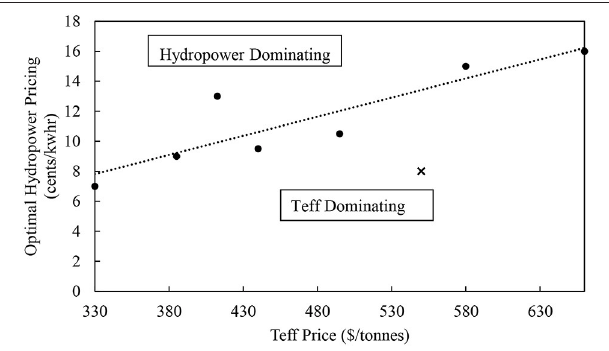
FIGURE 11 | The optimal hydropower pricing at different teff market prices (The red cross indicates the current market price for teff and the hydropower pricing set by Ethiopia). The horizontal axis shows different Teff market prices while the vertical axis shows the corresponding electricity price that should be set by Ethiopia to not lose benefits due to potential agricultural expansion. The cross corresponds to the nominal prices of $550 per ton for teff and $0.08 per kwh for electricity. This figure was calculated using on the long-term average UBN basin hydrology.